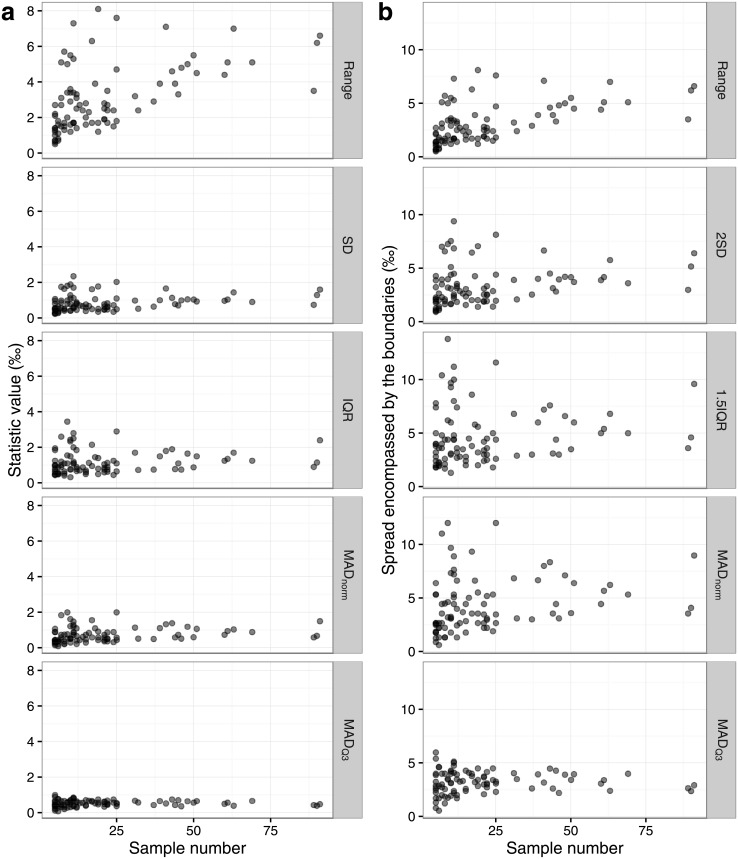
Comparison of the different measures of scale for each site in the Post-Infant Dentition data-subset plotted by site sample size, for all sites where N>4.On the left, (a) the statistic value for the range, SD, IQR and MADnorm and MADQ3. On the right, (b) the spread encompassed by the range, and the boundary values of the methods of 2SD, 1.5IQR, 3MADnorm and 3MADQ3. Criteria of each method (2SD, 1.5IQR, 3MADnorm, 3MADQ3) as defined in the text.